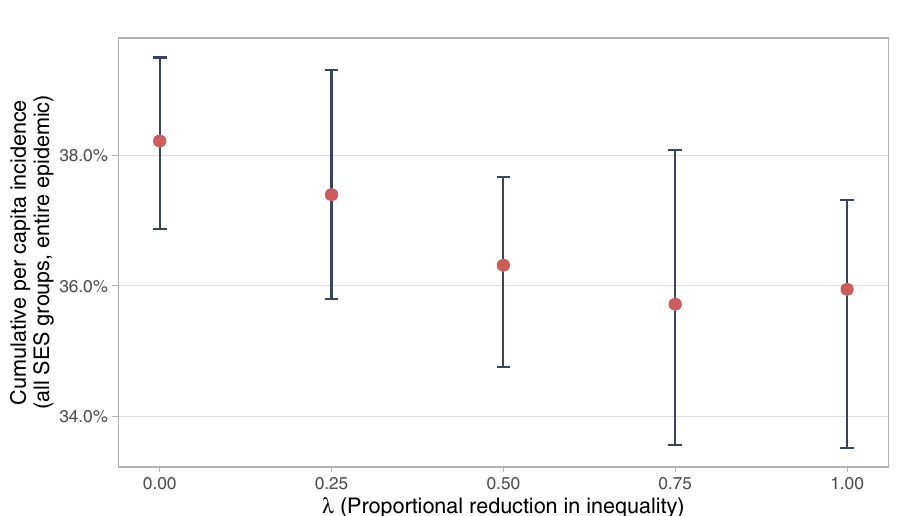
Figure 4. Mean-preserving reduction in inequalities. Describes the effect of reducing inequalities in all parameters simultaneously while preserving the mean of all parameters. The value of parameter k for an SES j in the baseline simulation can be written as v jk = v k + ε jk , where v k is the (population weighted) mean value for the parameter across all groups, and ε jk is some deviation. The graph plots the results of adjusting all parameters to the value v ∗ jk ( (cid:31) ) = v k + ( 1 − (cid:31) )ε jk . The outcome variable is the median cumulative per capita incidence across all SES over the course of the entire simulated epidemic in 50 models with no mobility change. Error bars indicate the 0.025 and 0.975 quantiles of the 50